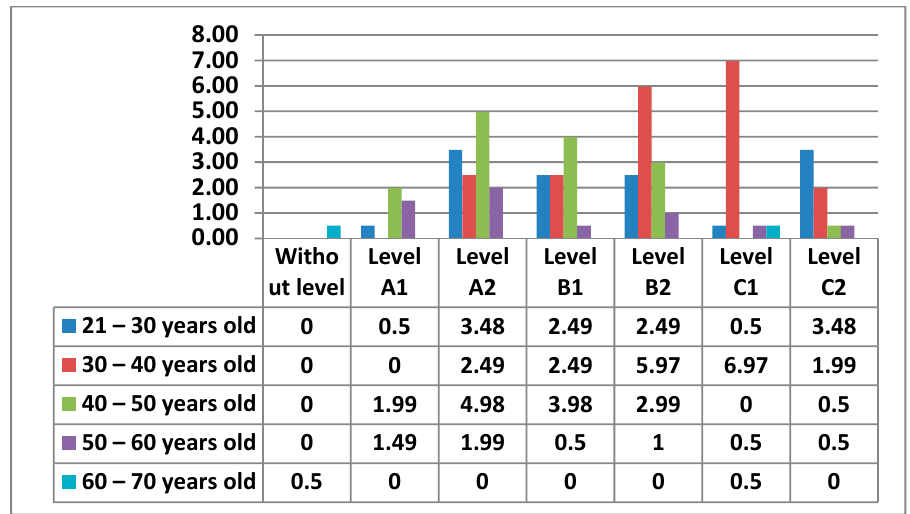
Figure 12. Level of digital competence in women by age in area 1.